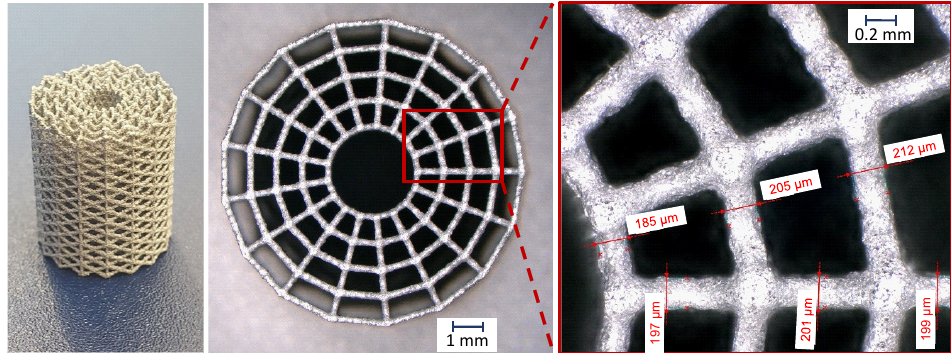
Figure 3. Resulting LPBF produced scaffold used for the physical